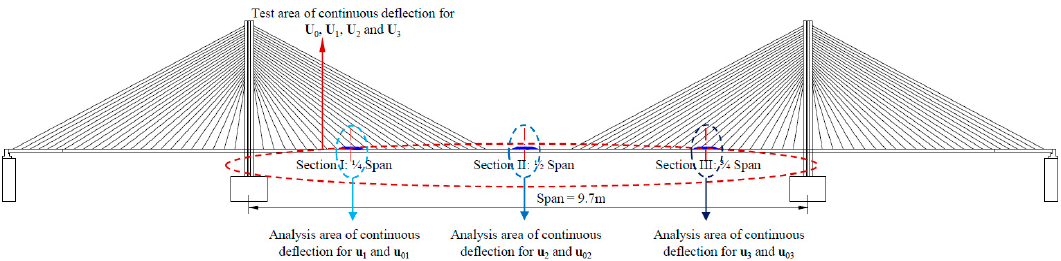
Figure 3. Locations of the metal pad used to assist in simulated damage scenarios.